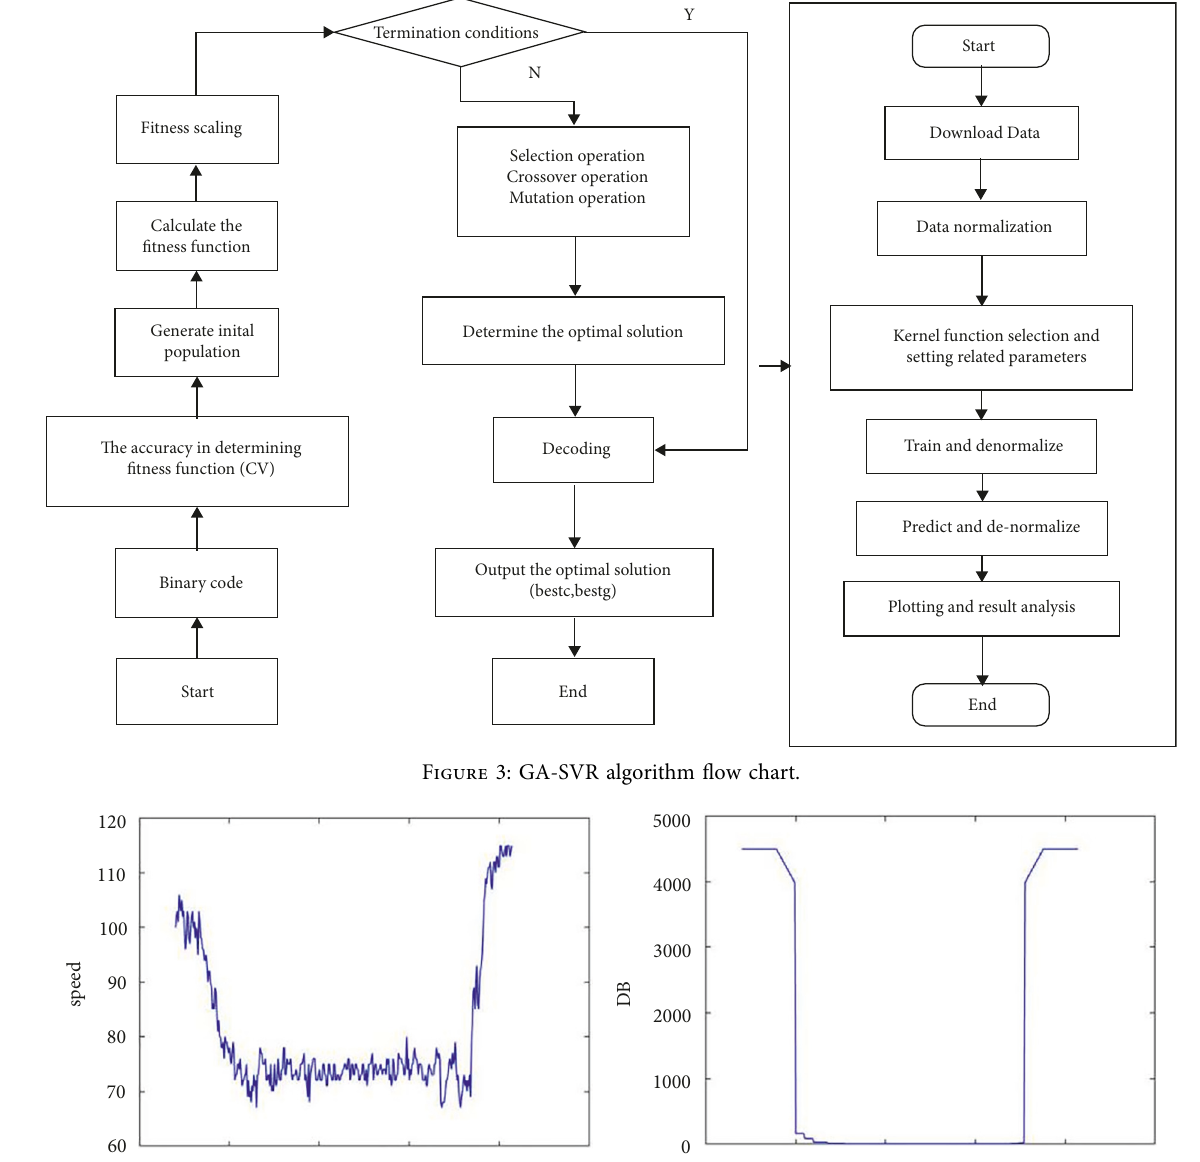
Figure 3: GA-SVR algorithm flow